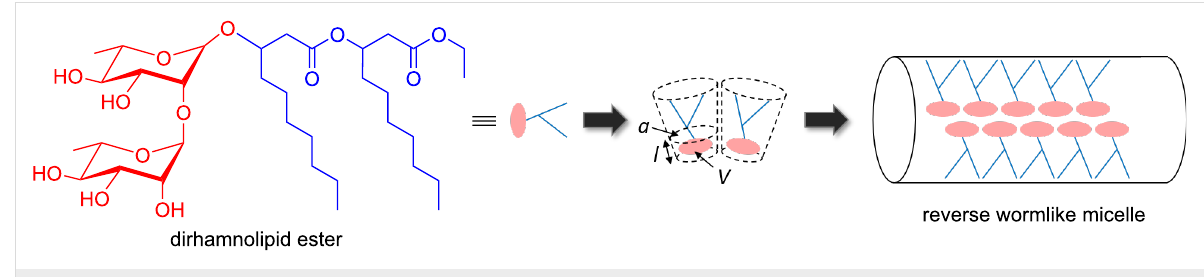
Figure 9: Schematic representation of the formation of RWLM by dirhamnolipid esters.